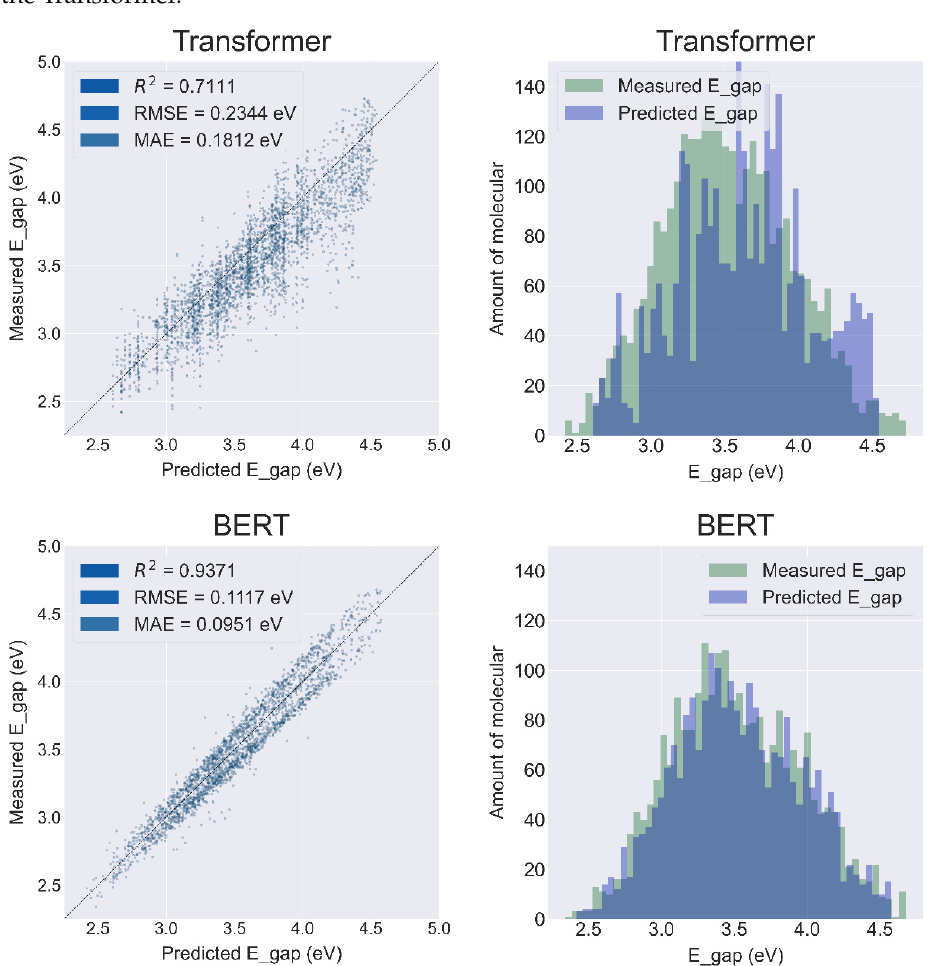
Figure 4. Results of the prediction sets for the Transformer and BERT